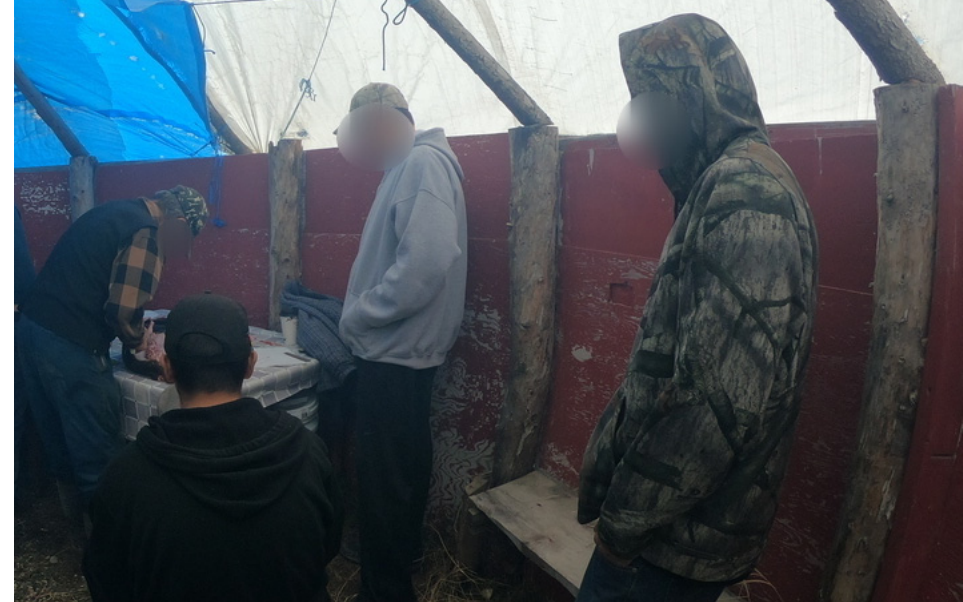
Figure 1. Youth and experts observing the skinning and smoking process for the beaver by an Elder.